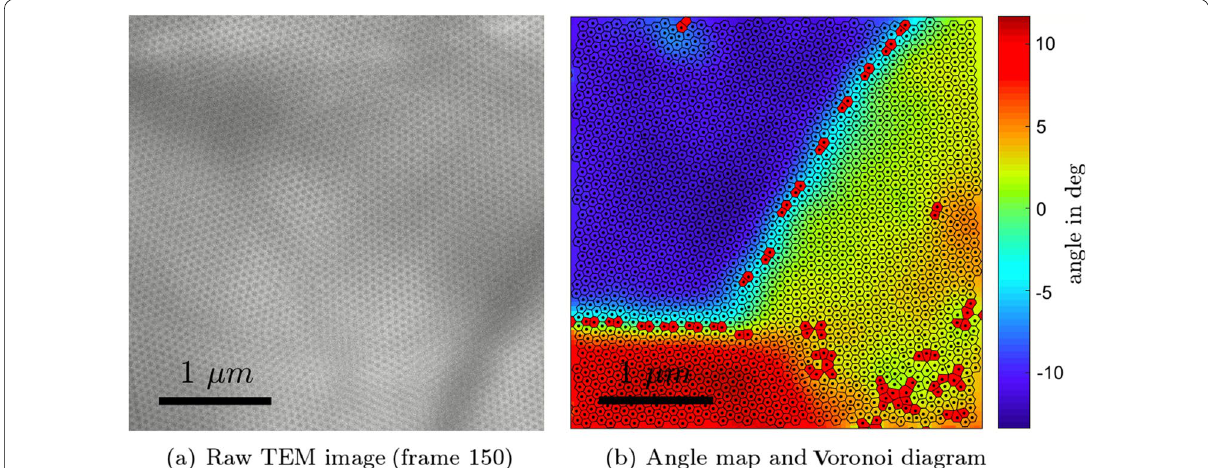
Fig. 1 Example of one TEM micrograph from the series of 579 TEM frames analysed in this study ( a ) and the angle map revealing the different lattice domains ( b ). The identified points are used to construct the Voronoi diagram ( b ). Transparent polygons are sixfold coordinated sites, red polygons are